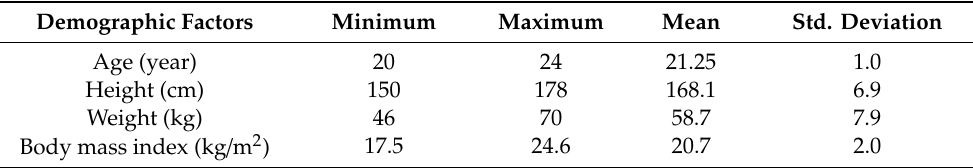
Table 1. Descriptive characteristics of the 20 participants.